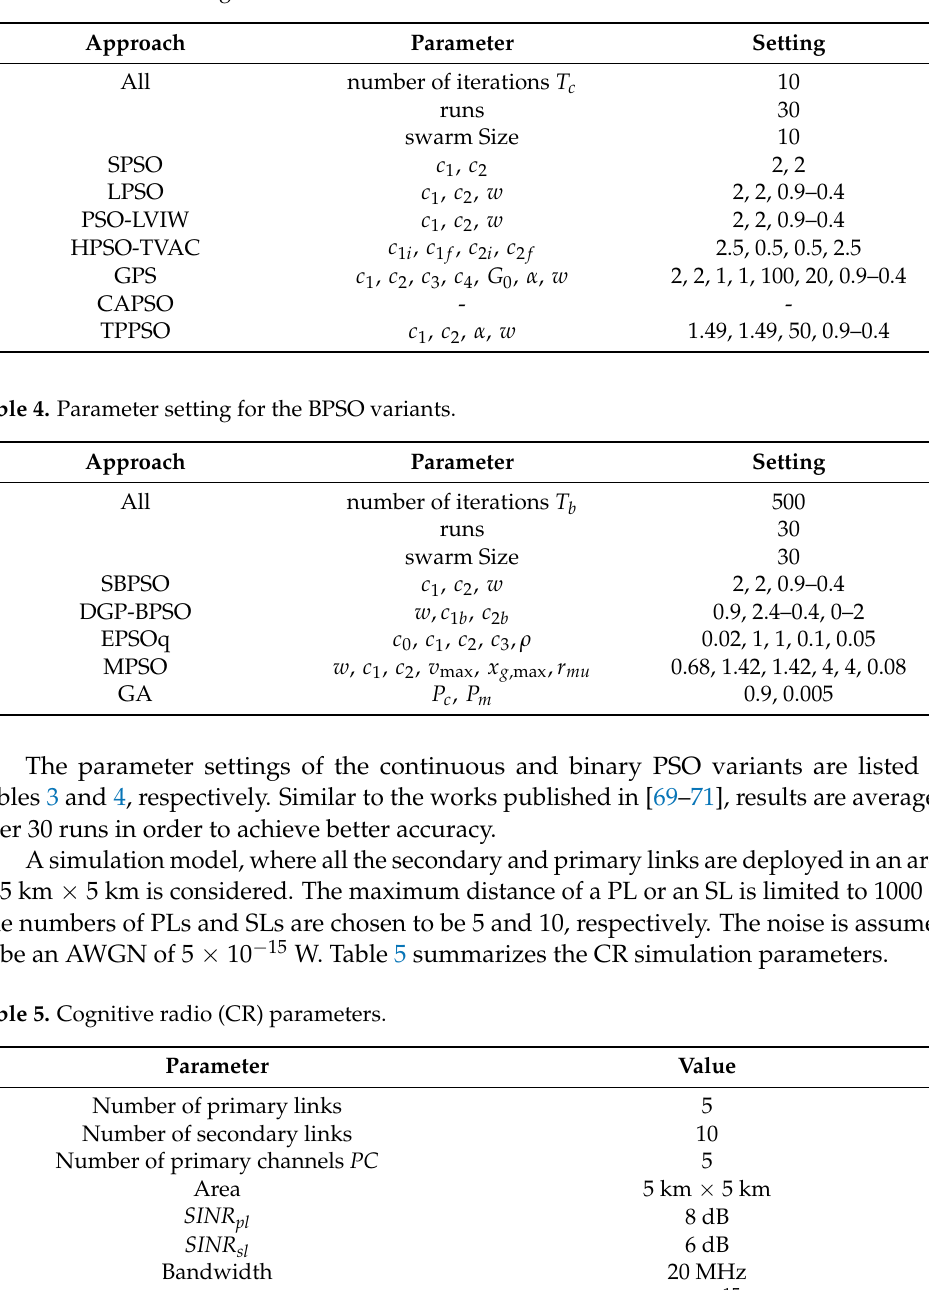
Table 3. Parameter setting for the CPSO variants.